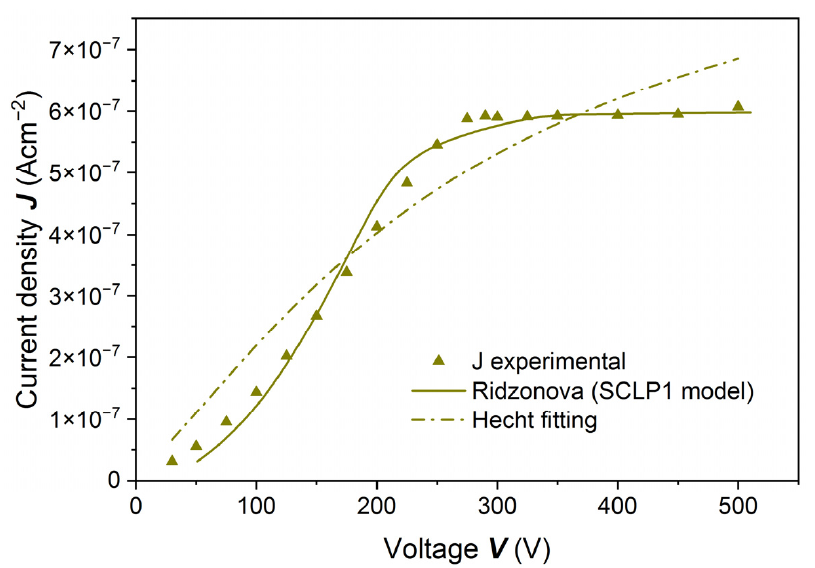
Figure 8. Current density J as a function of voltage V at the mean photon flux F = 8.49 × 10 12 cm − 2 s − 1 measured on a (Cd,Mn)Te:In sample etched with 20% HCl. The excitation energy was equal to ħω = 1.651 eV = E g + 76 meV. The dashed line is a fit with the Hecht formula, solid line is a fit with the Ridzonova et al. model [13].